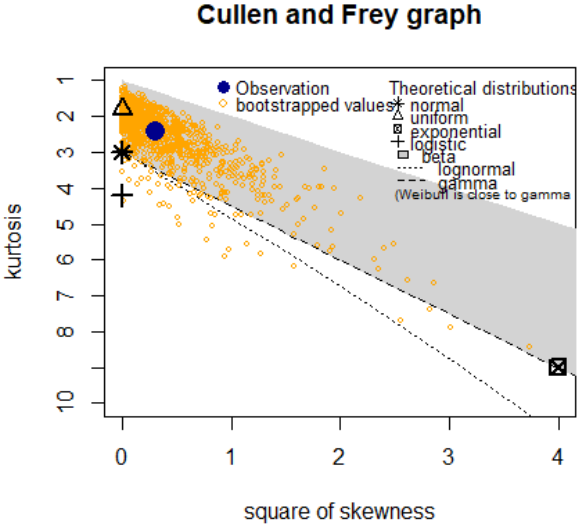
Figure 9. Estimated marginal distribution for non-HIV/AIDS for